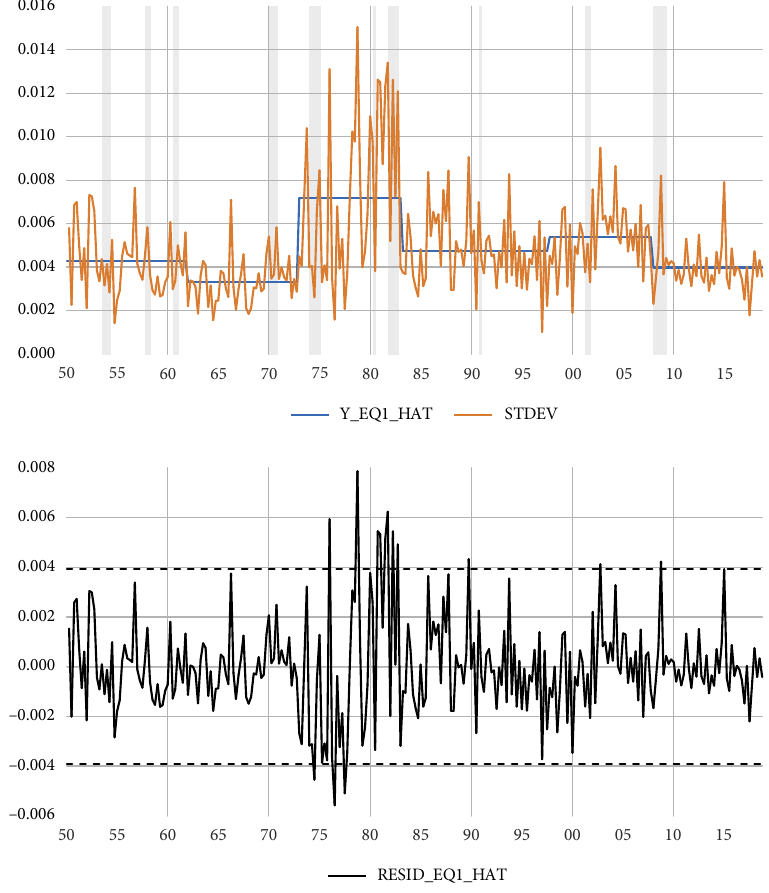
Figure 3. Univariate estimate of STDEV via BP method. Y_EQ1_HAT stands for the estimated values of STDEV whereas RESID_EQ1_HAT shows the residuals from the equation. Shaded areas in the top panel are the recession dates. These are NBER based recession indicators for the United States from the period following the peak through the trough, +1 or 0, quarterly, not seasonally adjusted (USRECQ) (source: Federal Reserve Bank of St. Louis,